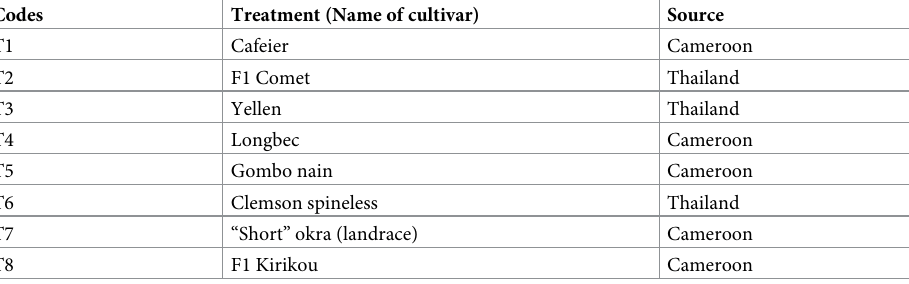
Table 1. Okra cultivars used in this study and their